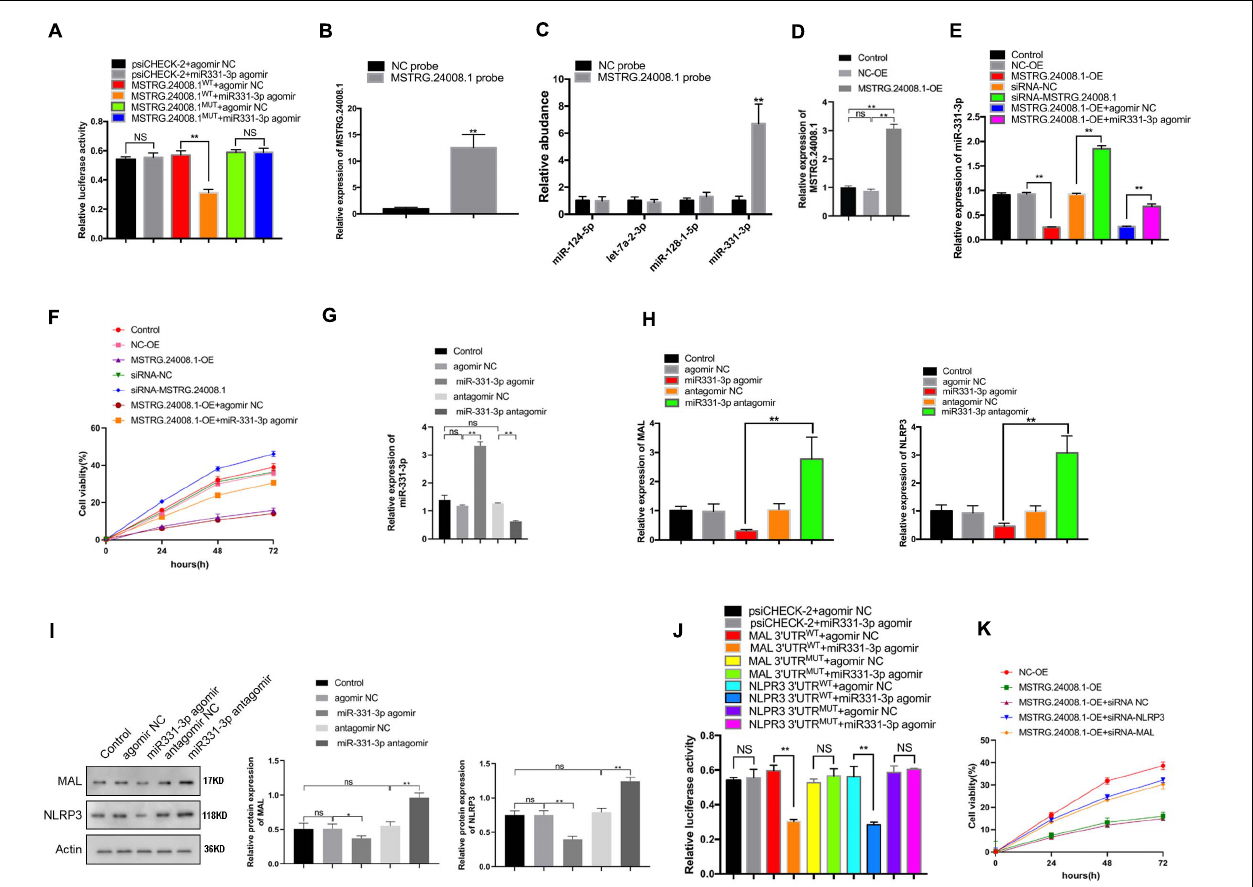
FIGURE 3 | MSTRG. 24008.1 regulated the expression of MAL and NLRP3 via miRNA-331-3p, thus regulating the proliferation of Schwann cells (A) Dual-luciferase reporter assay indicating that mir331-3p could bind with wild-type MSTRG.24008.1 . Student’s t -test, ** P < 0.01. Data are present as the means ± SD. (B) MSTRG. 24008.1 in Schwann cells was pulled down by a MSTRG. 24008.1 -specific probe and detected by qRT-PCR assay. (C ) miRNA-331-3p was pulled down by using a MSTRG. 24008.1 -specific probe. (D) qRT-PCR analysis demonstrated increased MSTRG.24008.1 expression in Schwann cells upon MSTRG.24008.1 overexpression. One-Way ANOVA, * P < 0.05, ** P < 0.01. Data are presented as the means ± SD. (E) qRT-PCR analysis showed the regulatory effect of MSTRG.24008.1 on miRNA-331-3p in Schwann cells. One-Way ANOVA, * P < 0.05, ** P < 0.01. Data are presented as the means ± SD. (F) MTT assay was used to detect the proliferation curve of Schwann cells. (G) qRT-PCR analysis showing that the expression of miR-331-3p was altered after the transfection of the miR-331-3p agomir or antagomir in Schwann cells. One-Way ANOVA, ** P < 0.01. Data are presented as the means ± SD. (H) The mRNA expression level of MAL and NLRP3 in response to miR-331-3p agomir or antagomir treatment as analyzed using qRT-PCR. (I) The protein levels of MAL and NLRP3 in response to miR-331-3p agomir or antagomir treatment as analyzed using western blotting. (J) Dual-luciferase reporter assay demonstrated that mir331-3p cold bind with MAL and NLPR3. Student’s t -test, * P < 0.05, ** P < 0.01. Data are presented as the means ± SD. (K) The cell proliferation curve of Schwann cells treated with suppression of MAL or